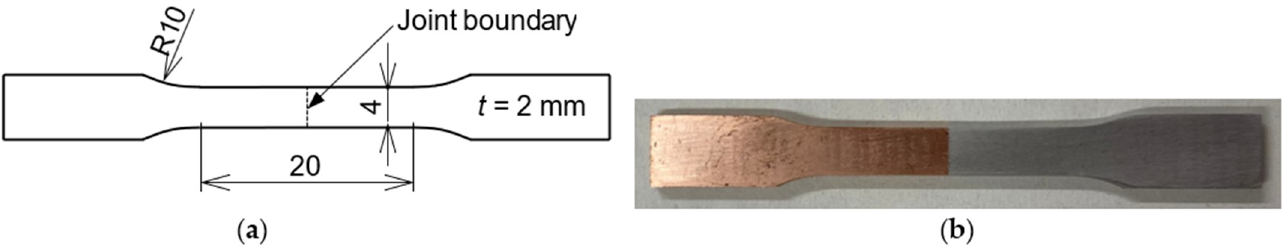
Figure 14. Cross-section of joint boundary using shaved surface: ( a ) Shaving allowance: C1100 1.0 mm, A6061 0.9 mm, overlap length: 0.1 mm; ( b ) Shaving allowance: C1100 1.0 mm, A6061 0.7 mm, overlap length: 0.3 mm.